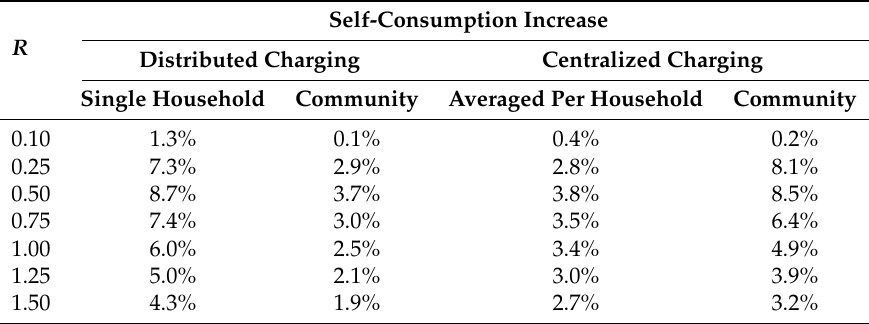
Table 1. Self-consumption improvements by smart charging schemes for a single household and on the community level with both distributed and centralized charging approaches.